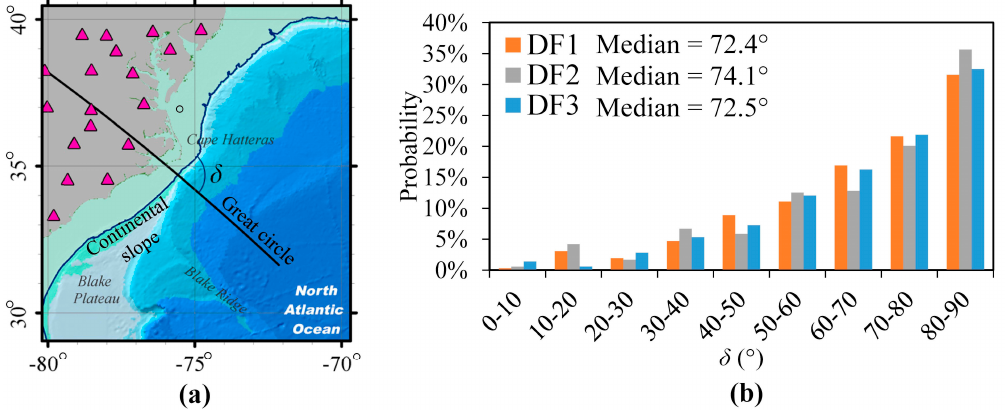
Figure 8. ( a ) Defining the angle 𝛿 (<90°) between a great circle and the continental slope’s strike. ( b ) Histogram of the angles 𝛿 s in the three DF bands.